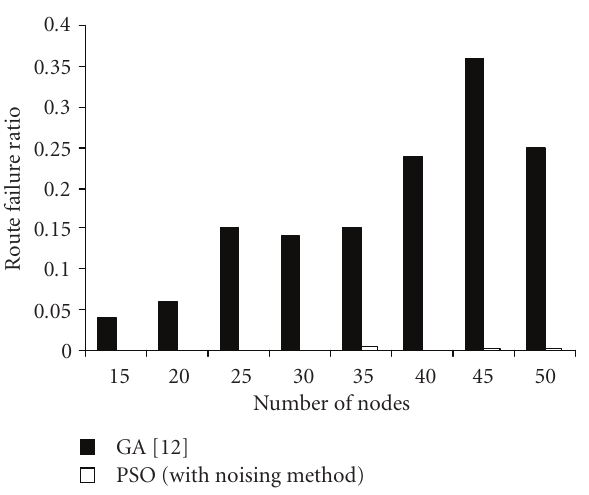
Figure 4.7 . Comparison of route failure ratio between proposed hybrid PSO and GA [12].